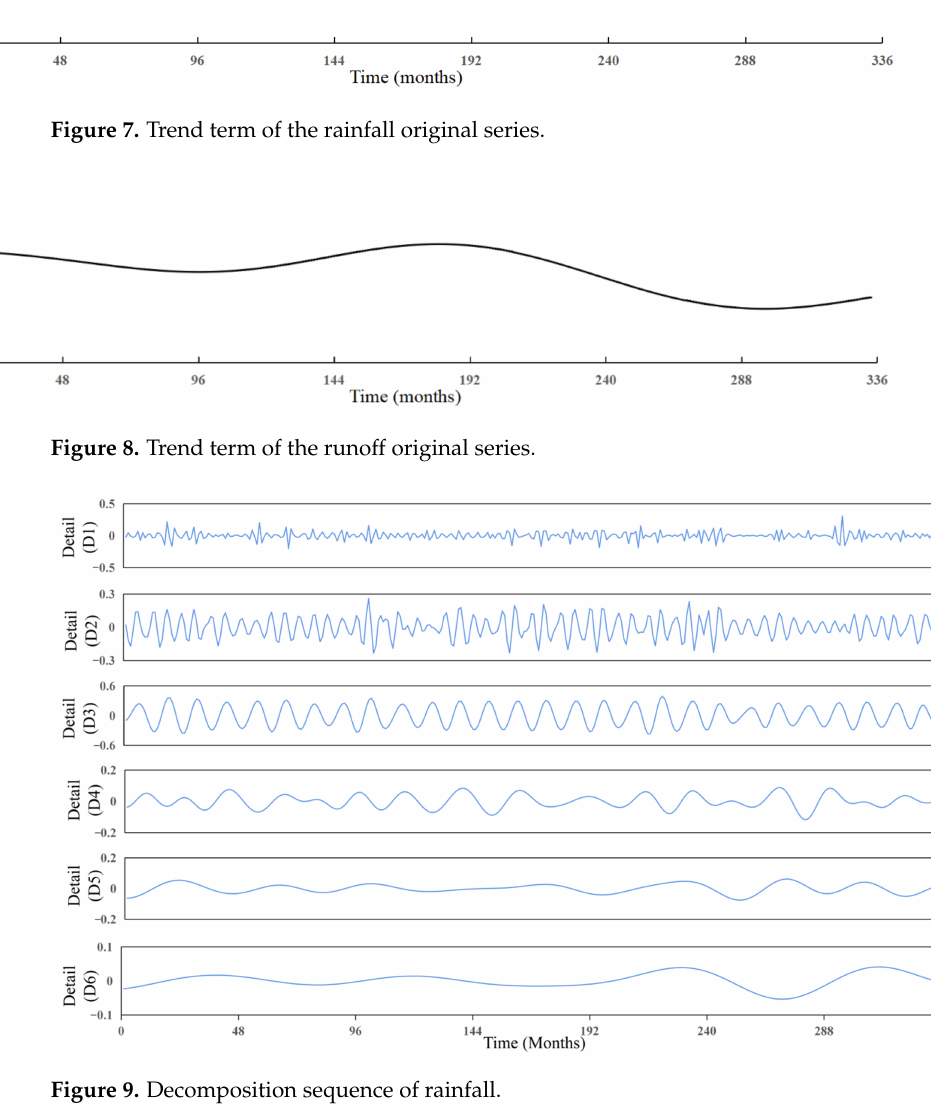
Figure 9. Decomposition sequence of